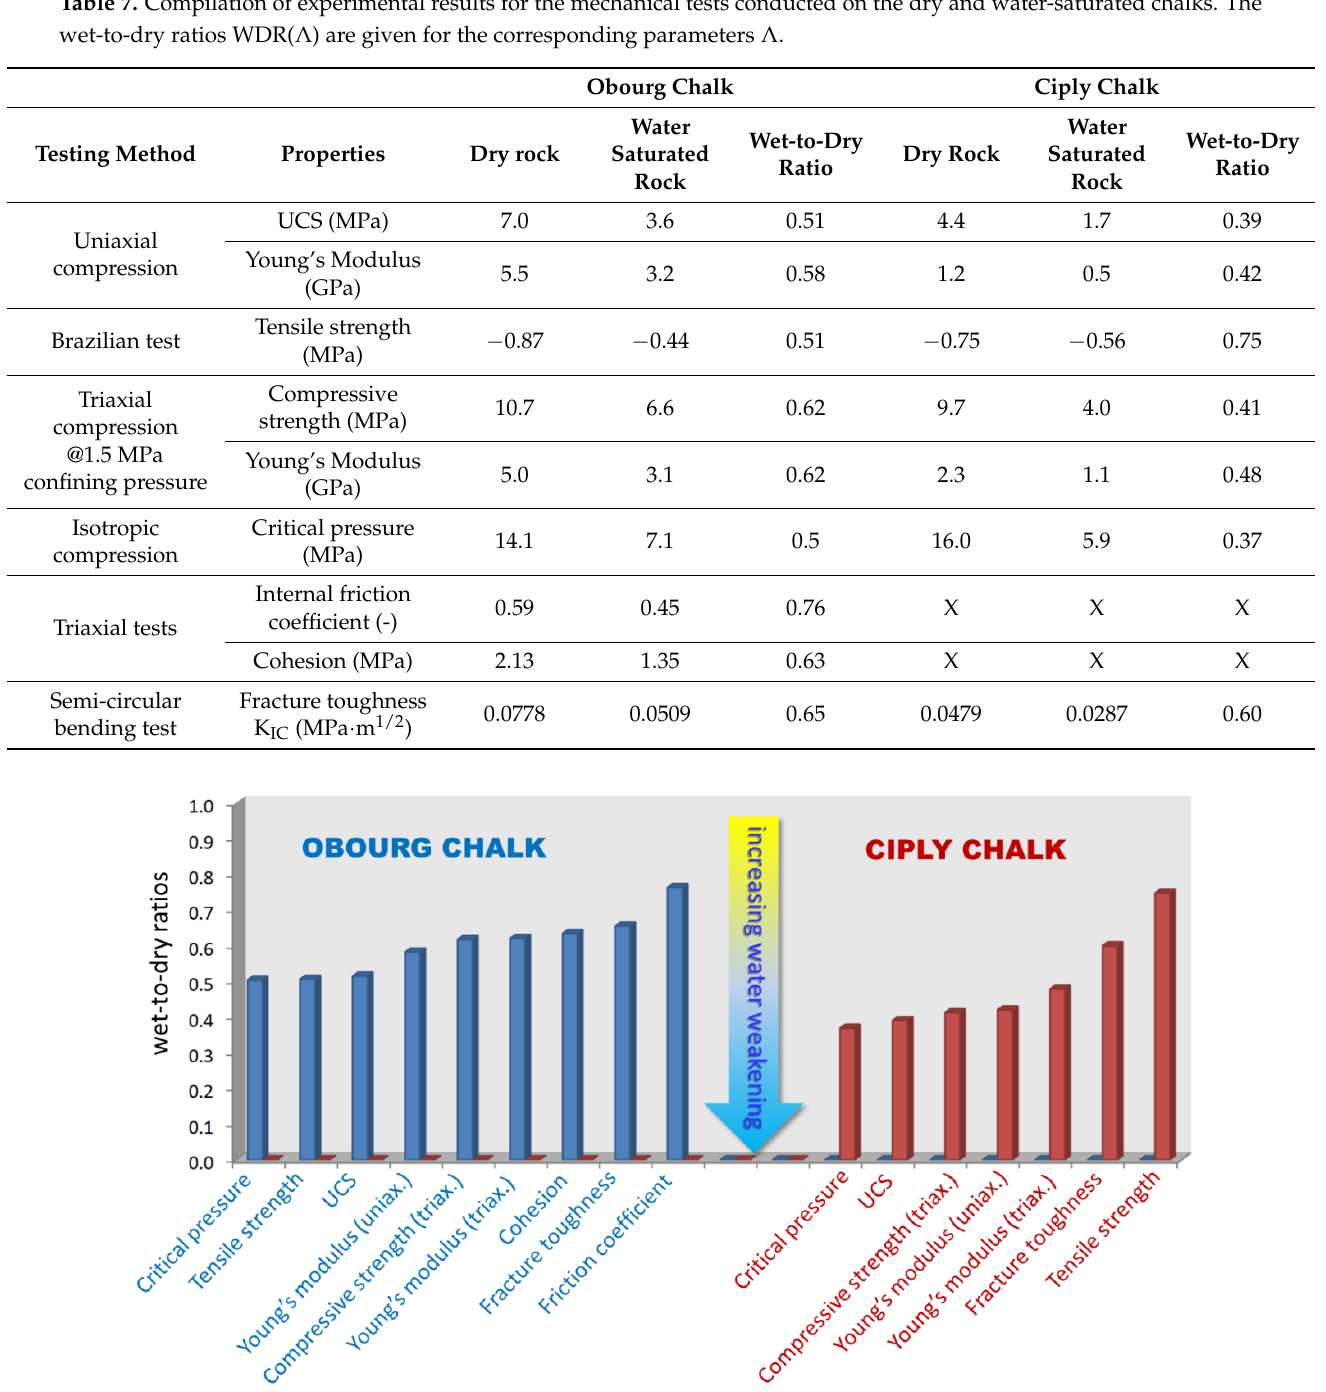
Figure 16. Bar chart with the wet-to-dry ratios in increasing order for each